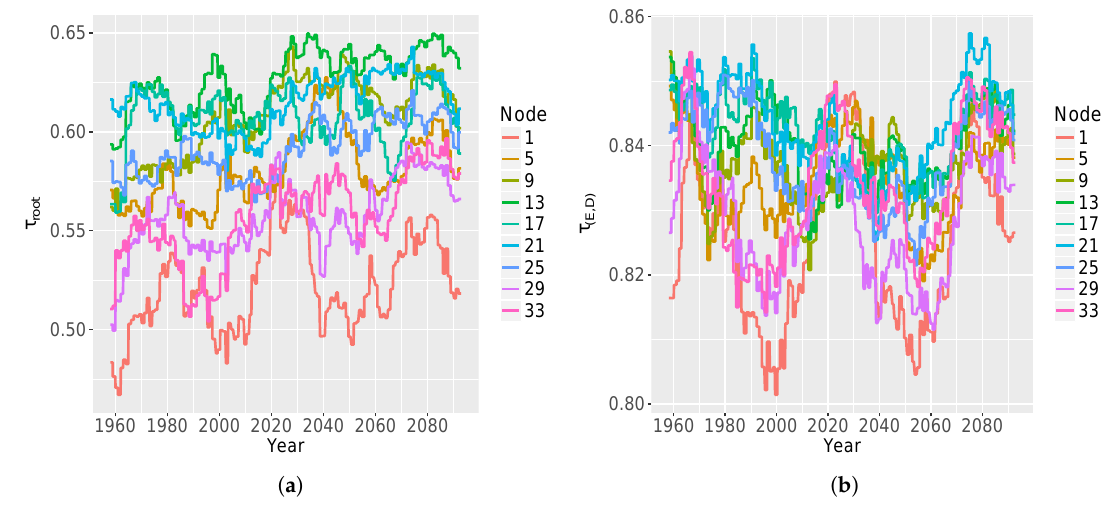
Figure 9. The dependence-parameter τ of ( a ) all the storm components and ( b ) the subset E - D , under the RCP8.5 scenario. Selected nodes serve to represent the results. Note that the scales for τ are different for